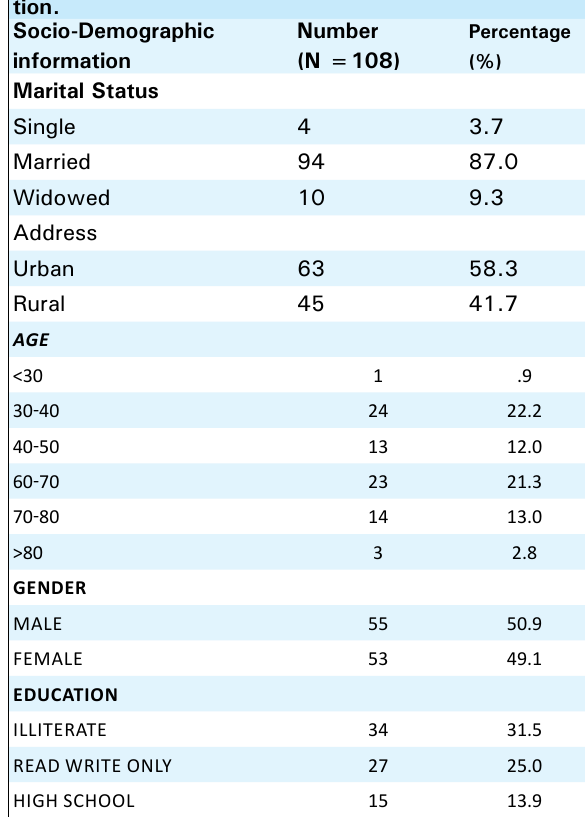
table 1. demographic characteristics of study popula- tion.